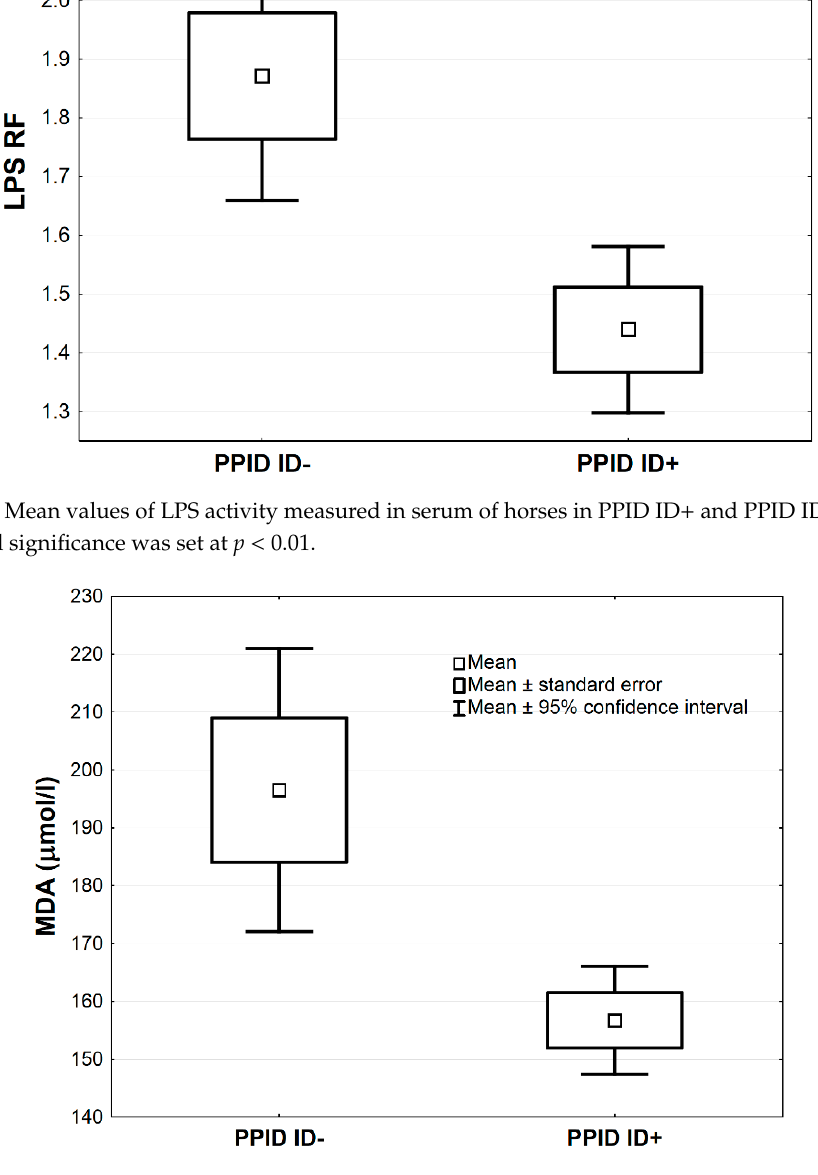
Figure 5. Mean values of serum malondialdehyde (MDA) activity in PPID ID + and PPID ID − group. Statistical significance was set at p < 0.05.